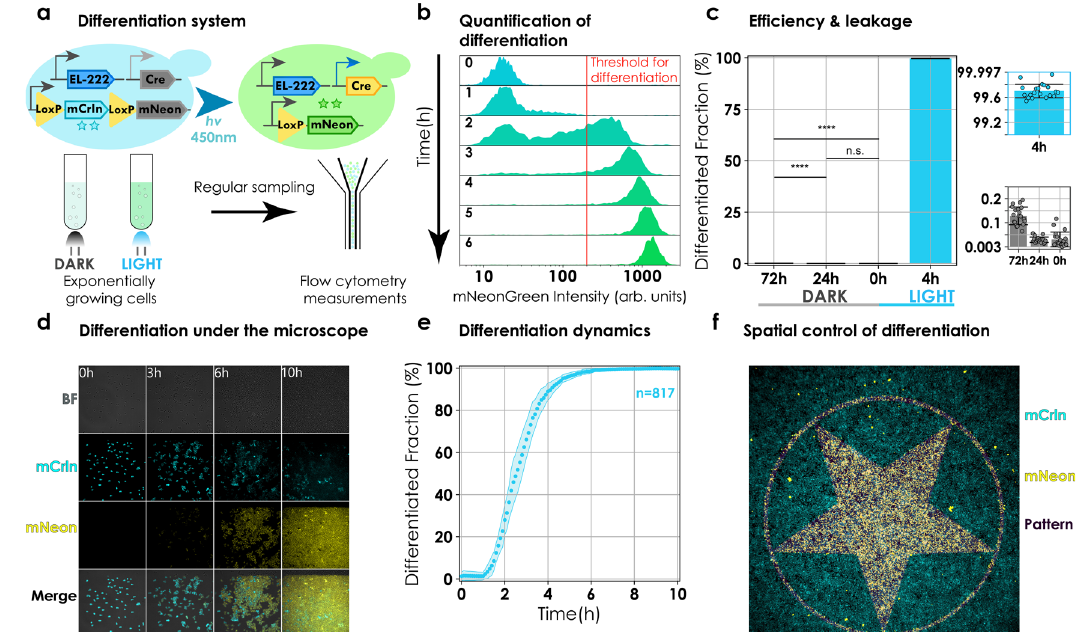
Fig. 1 Design and functional characterization of the differentiation system in liquid and 2D cultures. a Design and experimental setup. Cells constitutively express EL222 optogenetic transcription factor. Blue light triggers expression of Cre and recombination, and a change in fl uorescence from mCerulean to mNeonGreen. Cells carrying the differentiation system were cultured to exponential phase in batch and induced via LEDs. Cytometry measurements were made by sampling at regular intervals. b Quanti fi cation of differentiation. Cells are classi fi ed as differentiated if cellular mNeonGreen fl uorescence exceeds 200 arb. units (red line). The plot shows the evolution of population mNeonGreen fl uorescence as a function of time. The threshold was set such that only cells that have expressed detectable amounts of mNeonGreen are classi fi ed as differentiated. c Ef fi ciency and background differentiation. Twenty colonies were picked and cultured in batch for 72 h in dark or induced at t = 0 for 4 h. Measurements were taken at t = 0, t = 24 h and t = 72 h. Bars represent means from a single experiment. Error bars signify standard deviation. Individual data points from colonies are depicted in a scatter plot overlaid on the bar plot (blue and grey insets). Increase in differentiated fraction was not signi fi cant (n.s.) after 24 h ( p = 0.41) but became signi fi cant at 72 h ( p = 5.3e − 08; two-sided paired t -test) (black horizontal lines). d Snapshots of cell growth and differentiation under the microscope. Images during induction from a representative fi eld of view. Cellular fl uorescence changes from mCerulean (cyan) to mNeonGreen (yellow) (Supplementary Movie 1). e Differentiation dynamics under the microscope. Images were segmented and analysed. To be deemed differentiated, median cellular fl uorescence had to exceed 300 arb. units mNeonGreen fl uorescence. Circles represent mean differentiated fraction over eight fi elds of view from two independent experiments. Shaded region shows standard error of mean. The total number of cells at t = 0 summed over all fi elds of view are given by n ( n = 817). f Imprinting patterns in the population. Cells were allowed to form a monolayer inside a µ Ibidi slide. A user-de fi ned pattern was illuminated over the monolayer using a digital mirror device (DMD). Merge consists of mCerulean fl uorescence (cyan), mNeonGreen fl uorescence (yellow), and the pattern